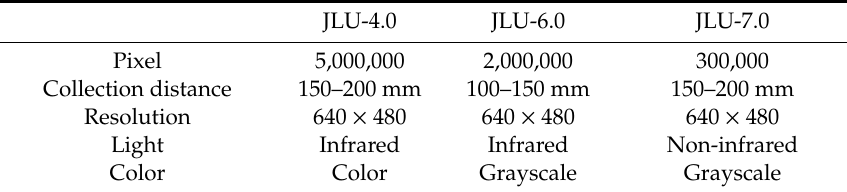
Table 1. The key indicators of the three acquisition